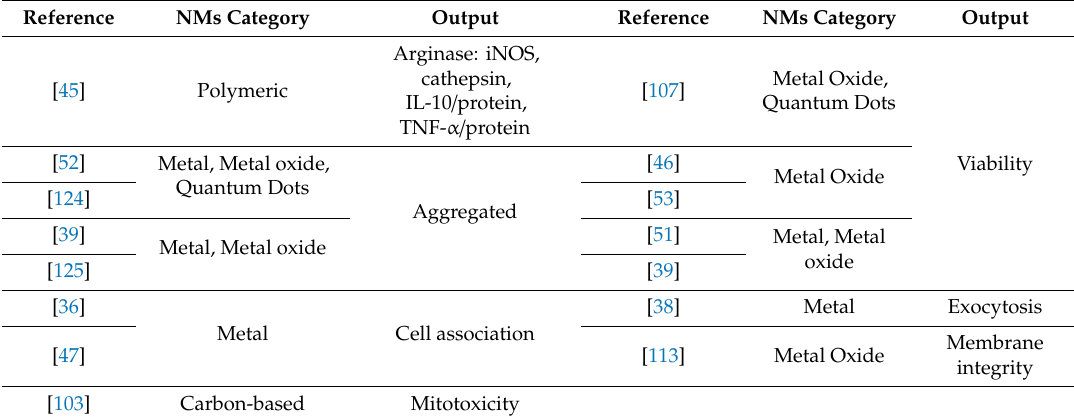
Table 7. Endpoints predicted by a dimensionality reduction extracted from the studies gathered.